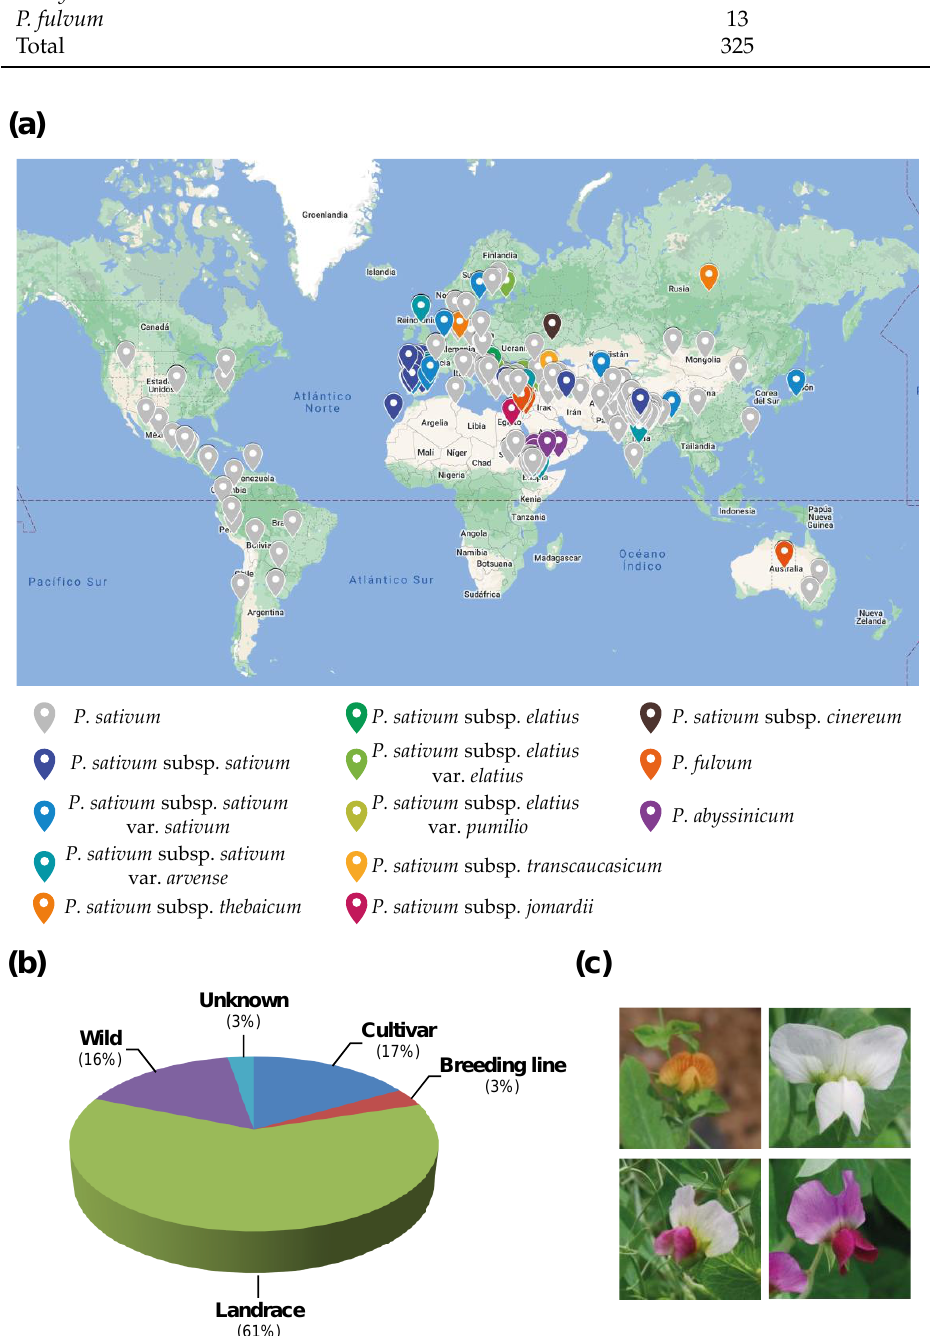
Figure 1. The IAS pea core collection. ( a ) Geographic distribution of the pea accessions that compose the IAS pea core collection based on Global Positioning System (GPS) data from available passport data. Different colours differentiate pea species or subspecies. ( b ) Distribution of the IAS pea core collection based on the plant material type (wild, landraces or cultivars). ( c ) Examples of the differ- ent types of flowers observed within the IAS pea core collection.